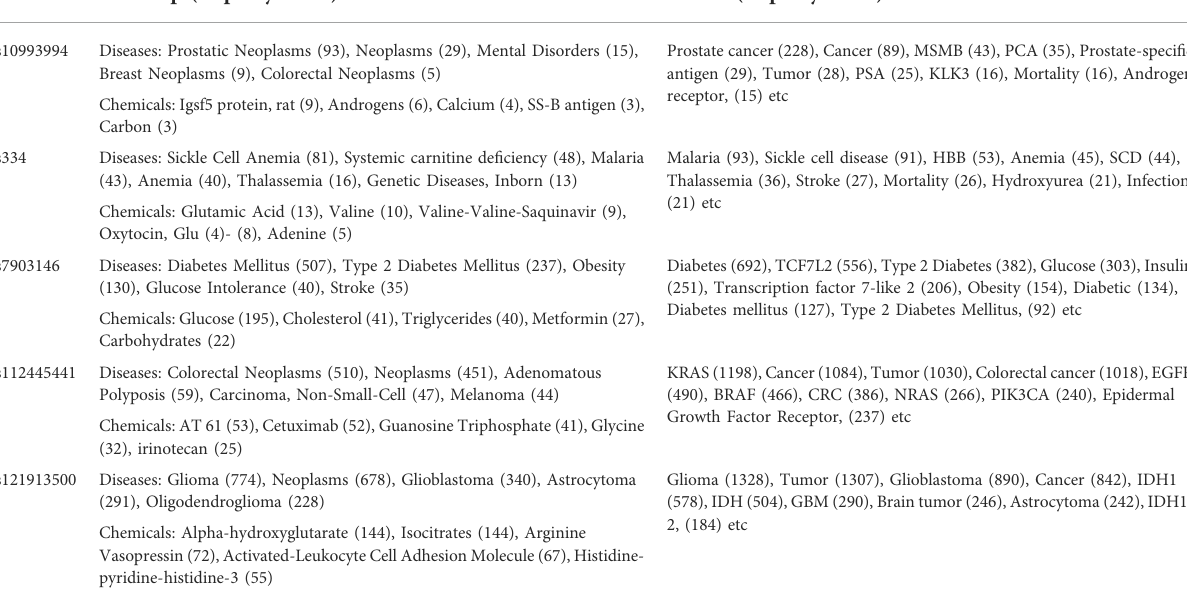
TABLE 3 Some selected SNPs and comparisons of their concepts under LitVar and SNPMap. SNPMap (Top keywords) LitVar (Top keywords)